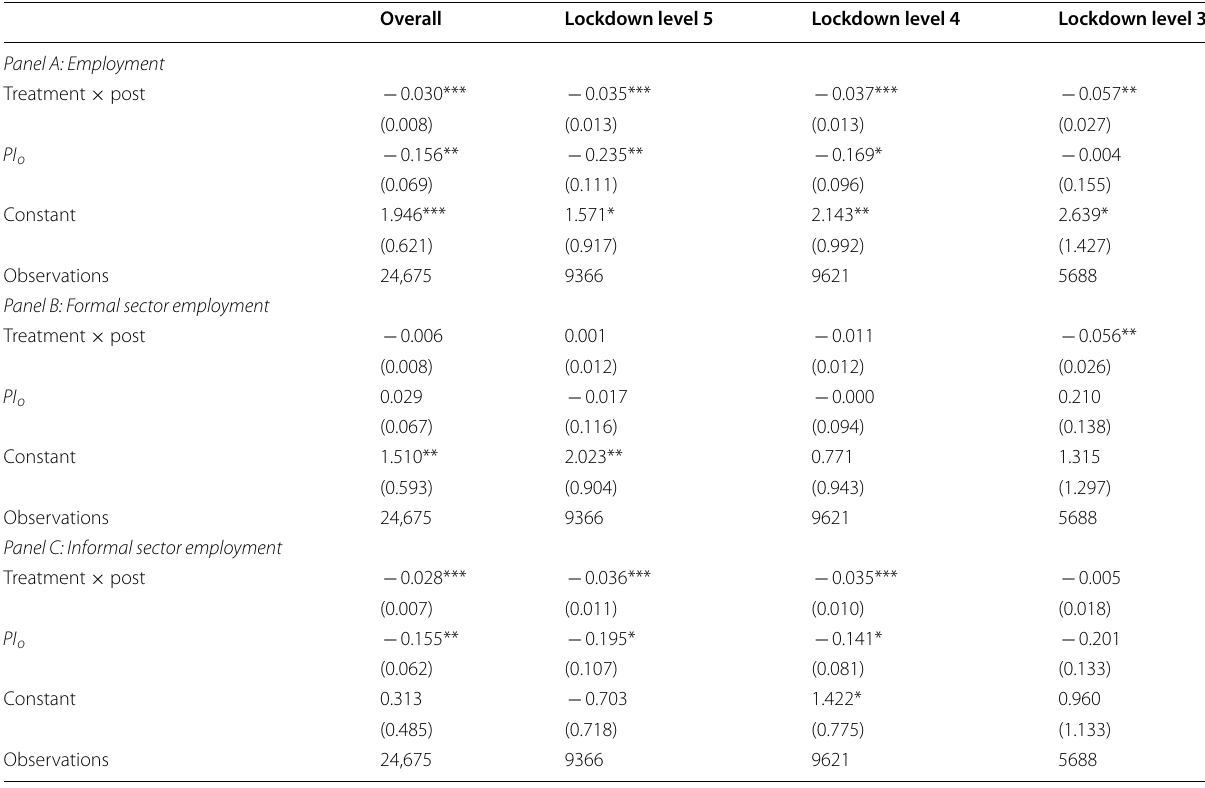
Table 7 Model estimates, controlling for occupation-level physical interaction. Author’s own calculations. Source : QLFS 2020Q1